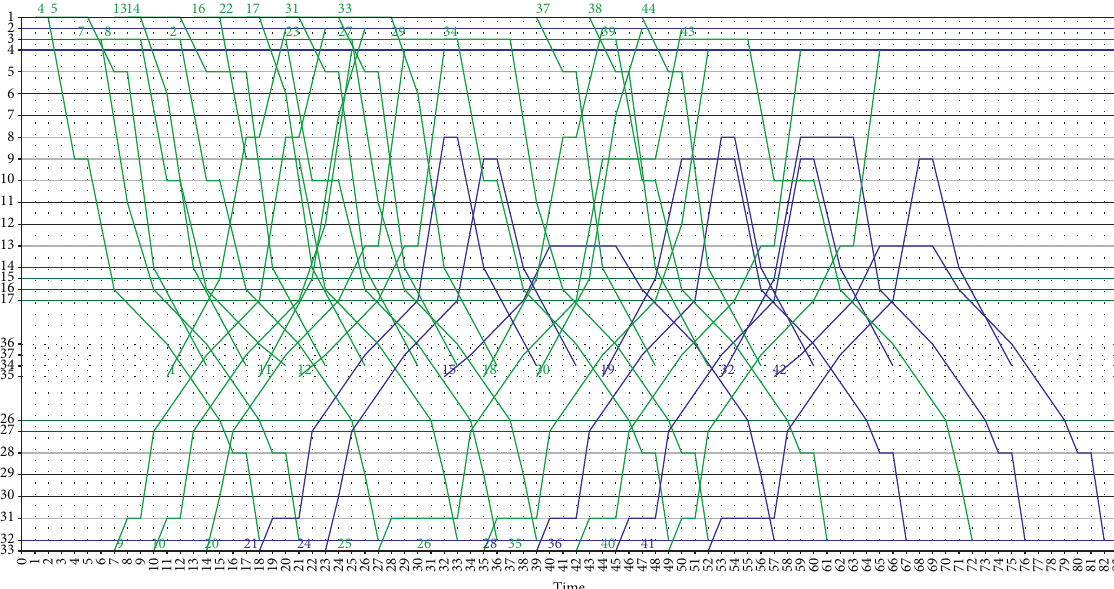
Figure 8: Train timetabling and platforming result for Line